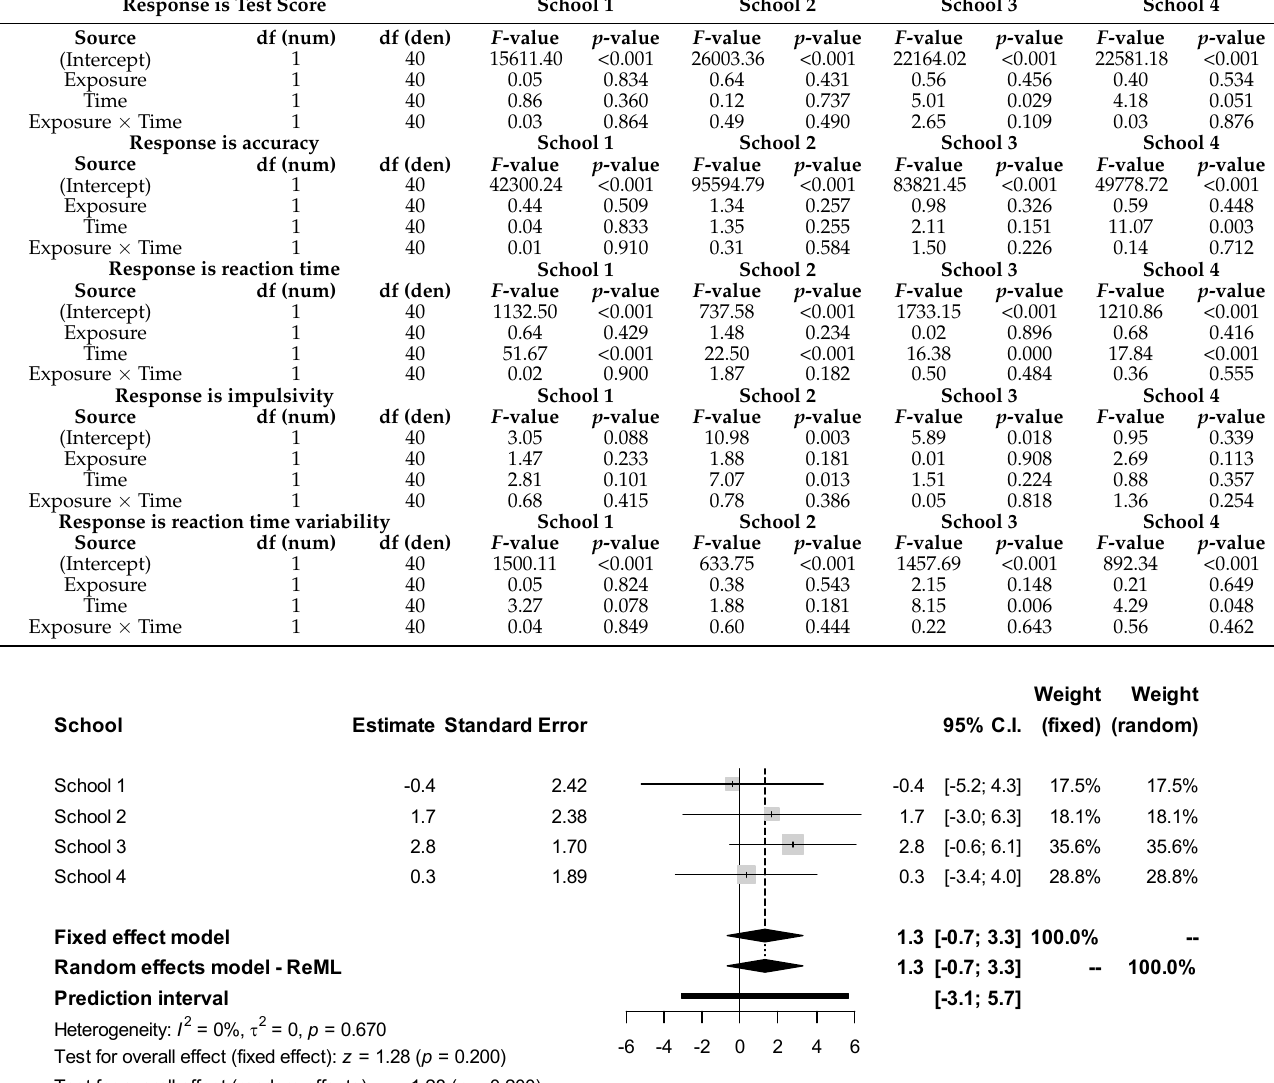
Figure 3. Meta ‐ analysis for test response accuracy.